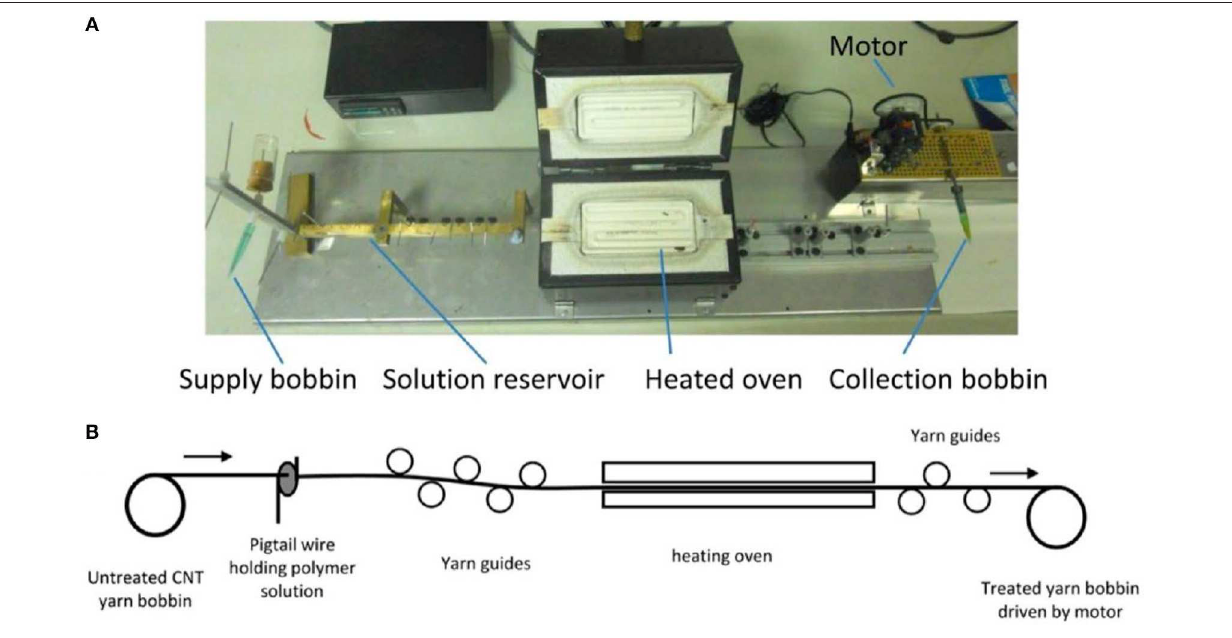
recently. The salt doped PEDOT has been proved to be directly